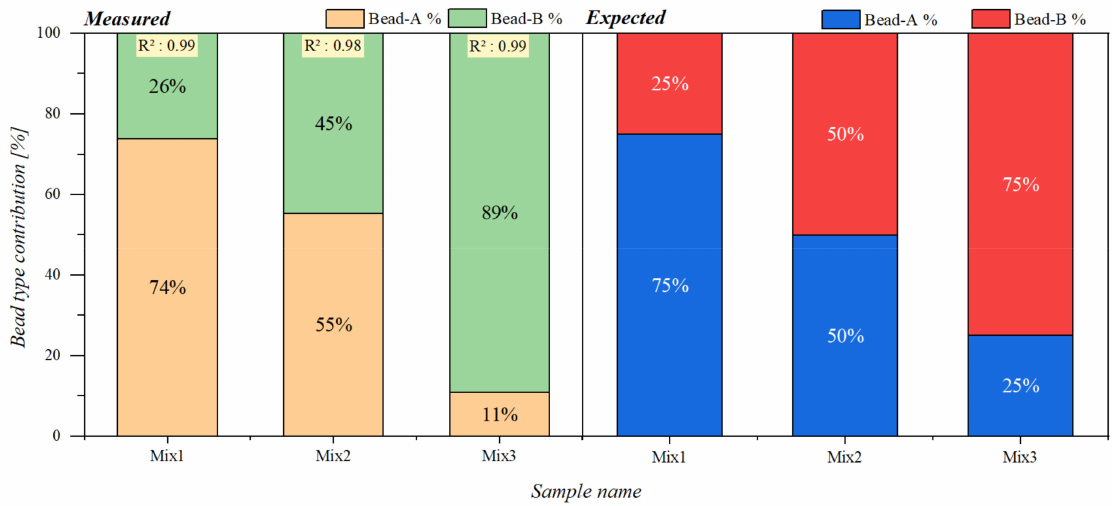
Figure 5. Bead type contributions for mixture samples containing beads A and B. The left chart presents the determined percentage of contributions from each reference bead type to the measured mixed samples. The right chart presents the expected contribution percentages of each bead type to the mixed samples.